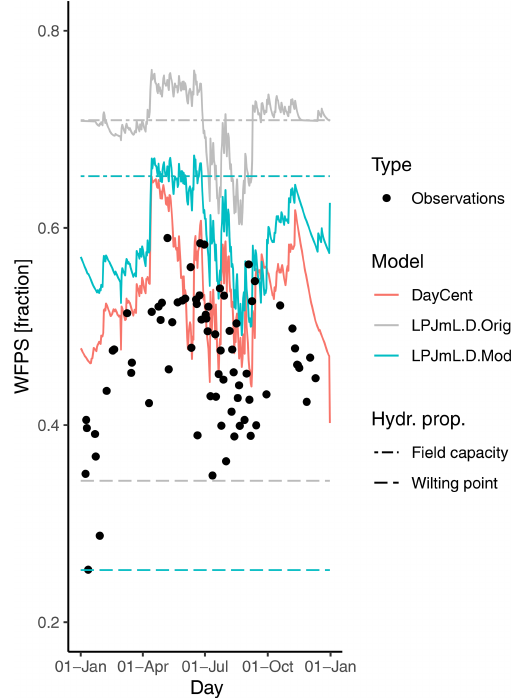
Figure 4. Observed and simulated soil moisture (fraction of the WFPS) of no-tillage in the top soil (0–20cm) in Nebraska.